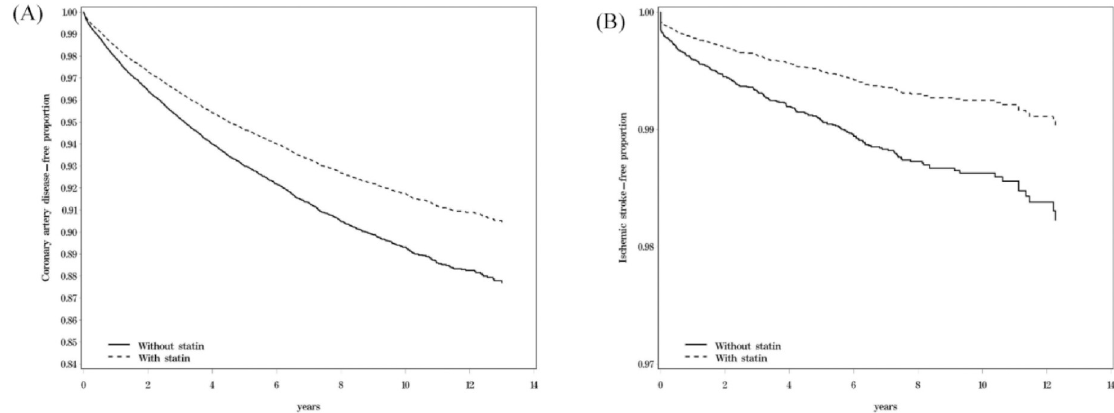
Fig 1. Coronary artery disease-free survival (A) and ischemic stroke-free survival (B) compared between patients with and without statin.